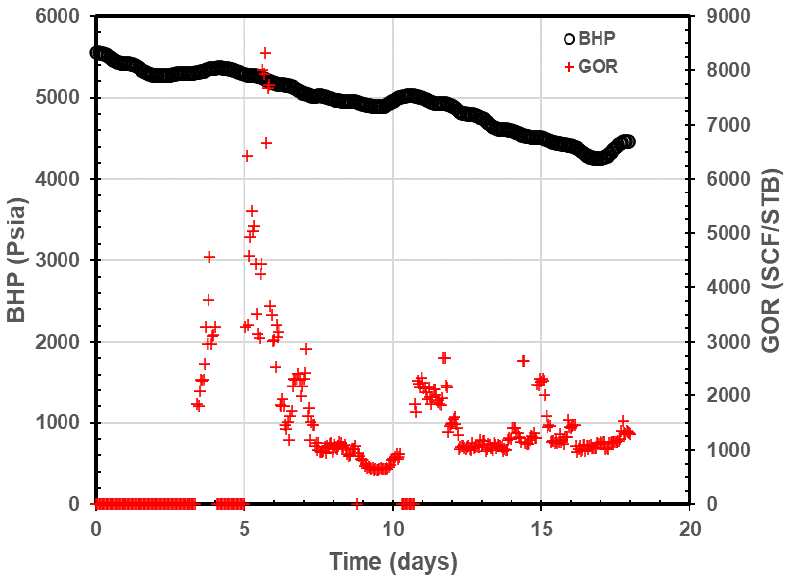
Figure 3. Field GOR variation during the flowback period. A significant GOR oscillation during the flowback period makes it difficult to select a constant GOR value for the fluid recombination.